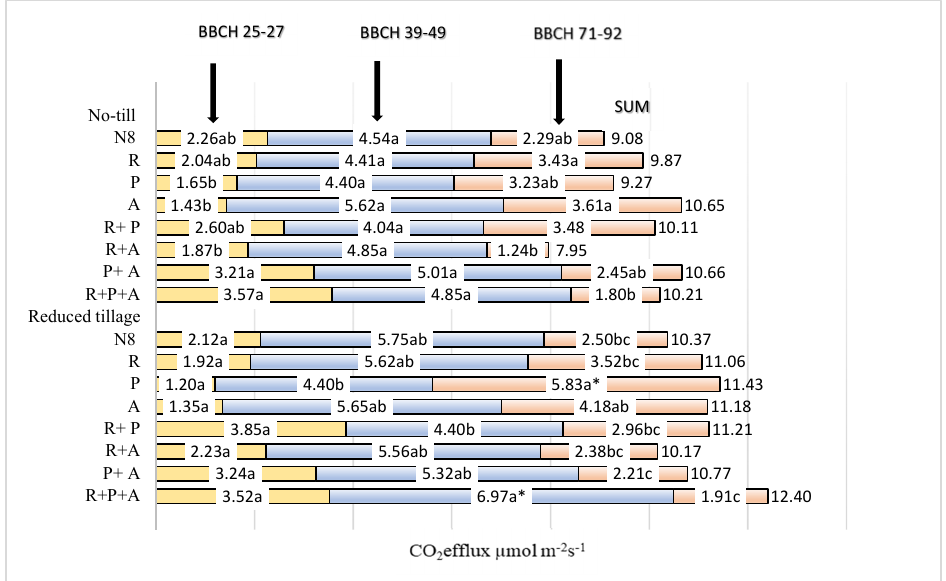
Figure 2. The influence of biostimulants on soil CO 2 emissions at the beginning, middle, and end of the vegetation period (2018). N8—compensatory nitrogen at 8 kg per ton of straw, without biological preparations; R— Ruinex 1 L ha −1 ; P— Penergetic k 0.2 L ha −1 ; A— Azofix 1 L ha −1 ; R + P— Ruinex 1 L ha −1 + Penergetic k 0.2 L ha −1 ; R + A— Ruinex 1 L ha −1 + Azofix 0.5 L ha −1 ; P + A— Penergetic k 0.2 L ha −1 + Azofix 1 L ha −1 ; R + P+A— Ruinex 1 L ha −1 + Penergetic k 0.2 L ha −1 + Azofix 0.5 L ha −1 . The averages of treatments marked with different letters (a, b, c ...) denote a significant influence of biostimulants and their mixtures; the averages of treatments marked with * denote significant influence of tillage technology, p < 0.05.